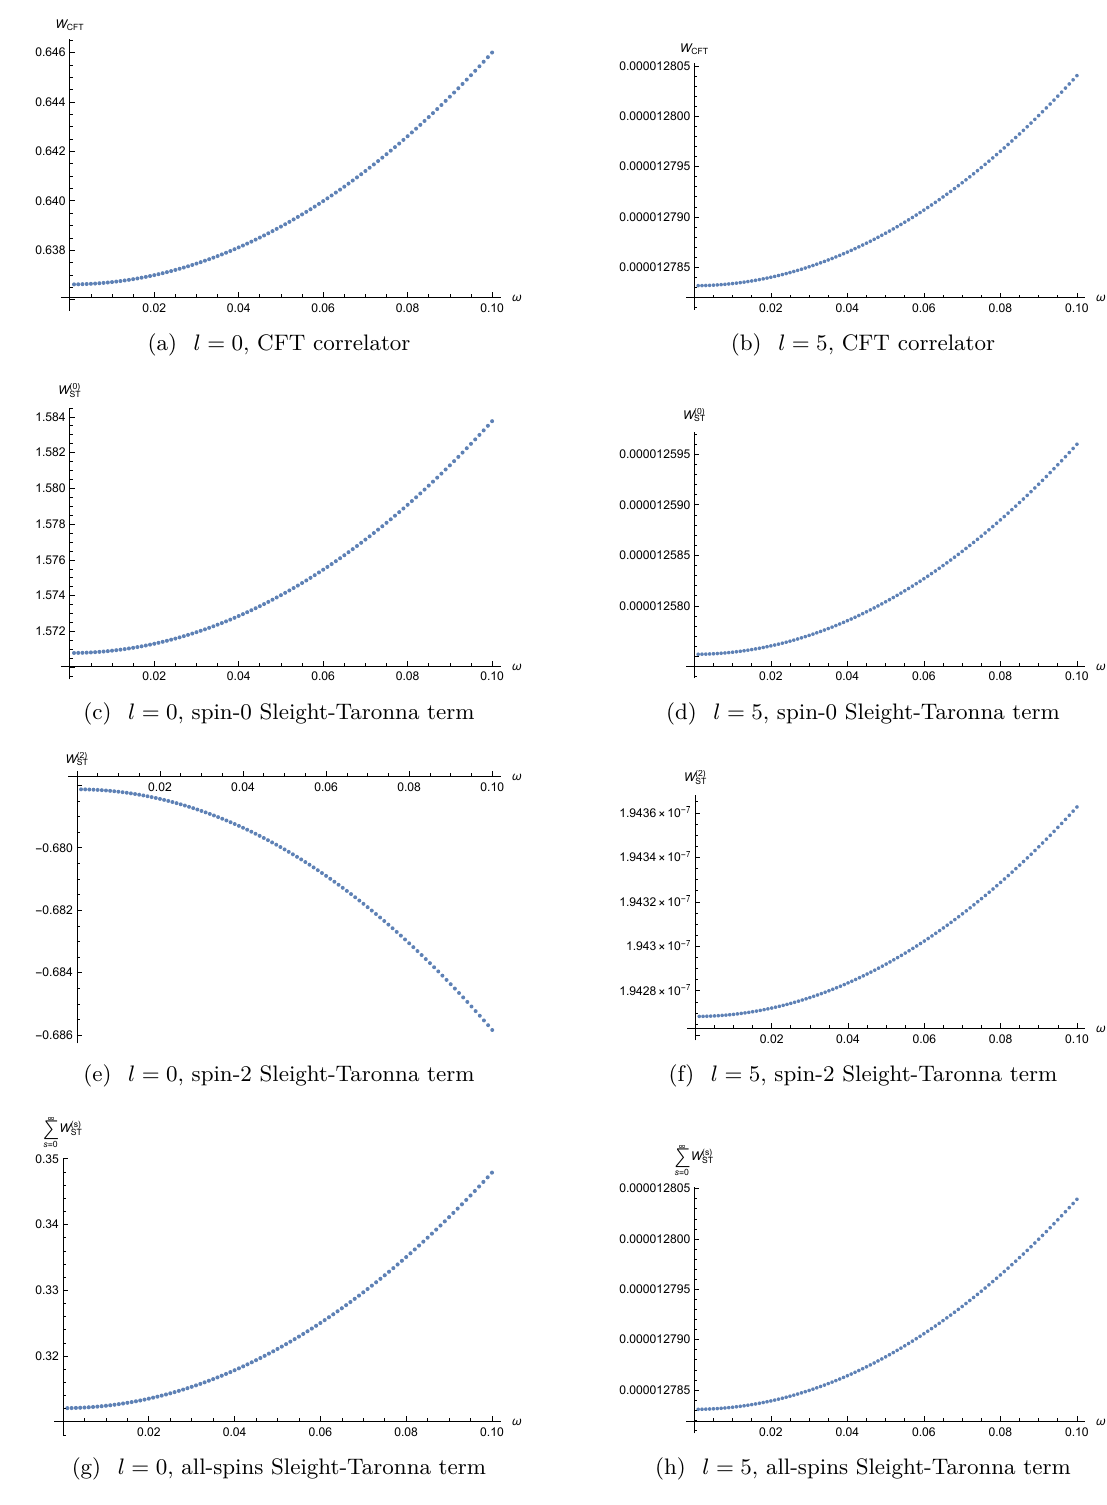
Figure 14 . Numerical plots of the CFT correlator and bulk Sleight-Taronna contributions in various channels, at l = 0 , 5 and 0 . 001 ≤ ω ≤ 0 . 1 . The regular behavior at ω → 0 expresses exponential decay at large “time” separations, which implies the “time” locality of the new